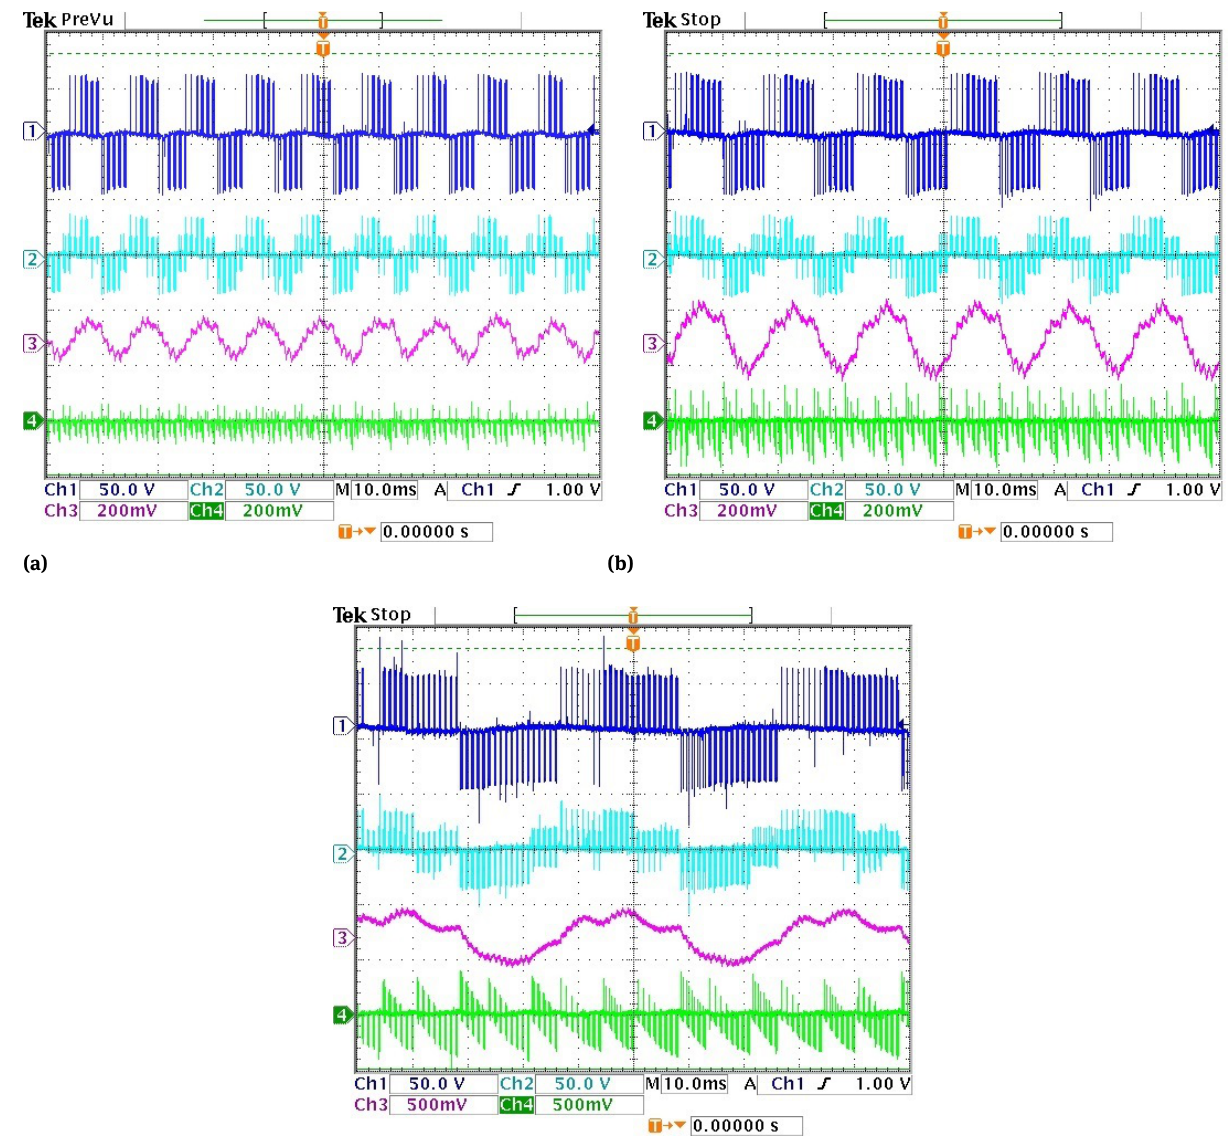
Note: All currents have been scaled down by a factor of 100. Figure 8: Experimental waveforms: line voltage (Ch1), phase voltage (Ch2), phase current (Ch3), and input DC current (Ch4) for (a) Inv 1; 95 Hz, (b) Inv 2; 60 Hz, and (c) Inv 3; 25 Hz